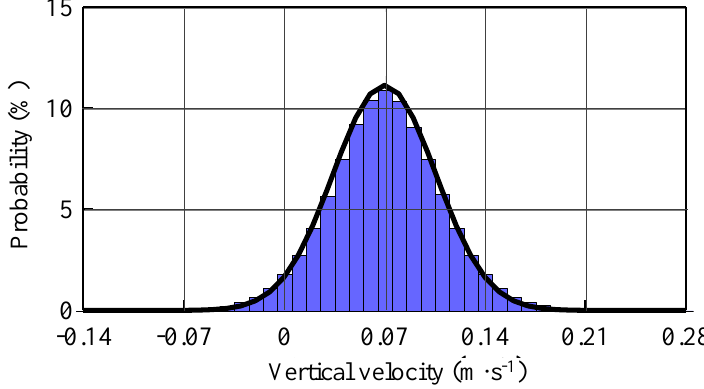
Figure 11. Probability distribution of the moving-averaged GPS output velocity (no signal loss or